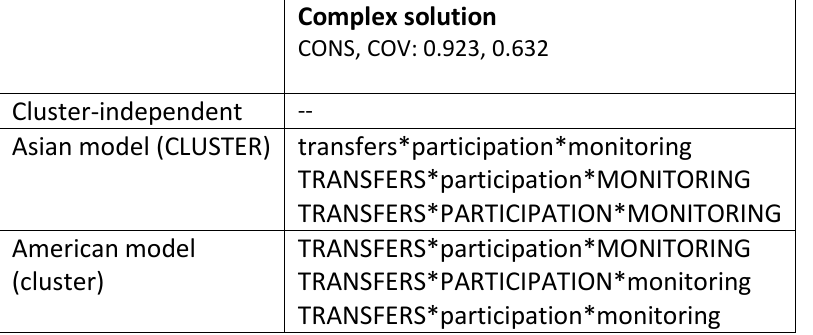
Table A2.5 Complex solution to successful drought adaptation (OUTCOME=1)